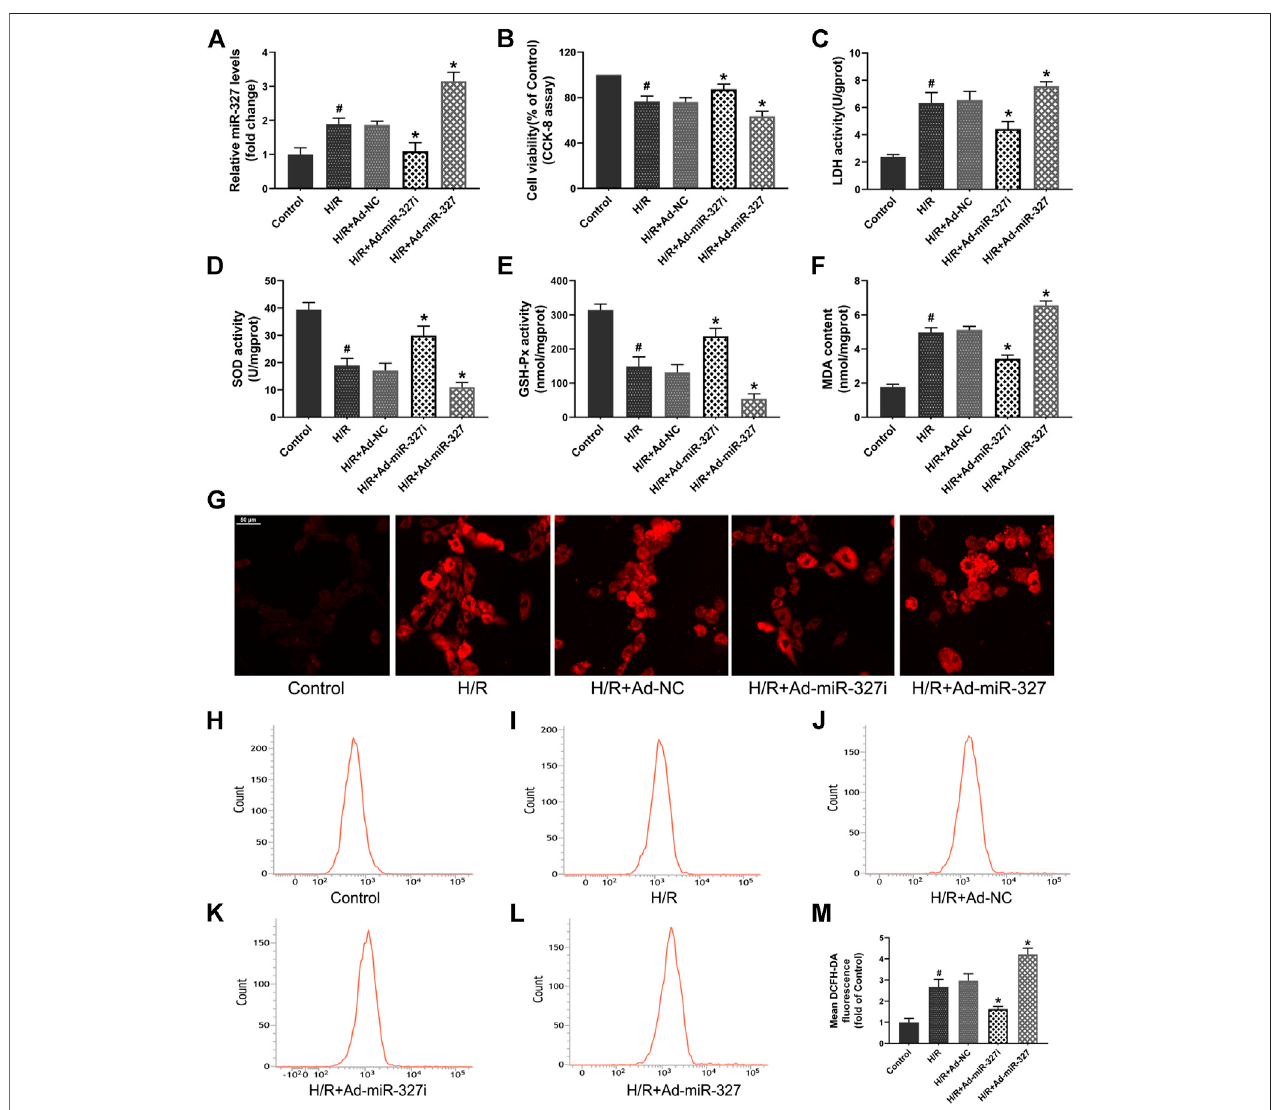
FIGURE 2 | Effects of miR-327 on oxidative stress in H/R H9c2 cells (A) . qRT-PCR detected the miR-327 expression levels in each group. The cell damage was determined by CCK-8 assay (B) and LDH activity (C) . Oxidative stress indexes of SOD (D) , GSH-Px (E) , and MDA (F) were detected after H/R treatment. The confocal lasermicroscopy showsimagesofintracellularROSstaining (G) .The fl owcytometryanalysiswasusedforquantitativeanalysisofDCFH-DA fl uorescenceofintracellular ROSineachgroup (H-L) ,andtheresultswereexpressedinbargraphs (M) .Allvaluesarepresented asthemean ± SD( n (cid:2) 3);# p < 0.05versustheControlgroup; * p < 0.05 compared to the Ad-NC